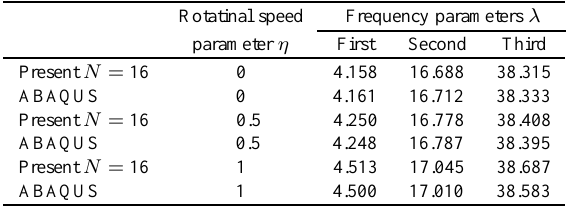
Table 6 Comparison of frequency parameters for non-rotating/rotating